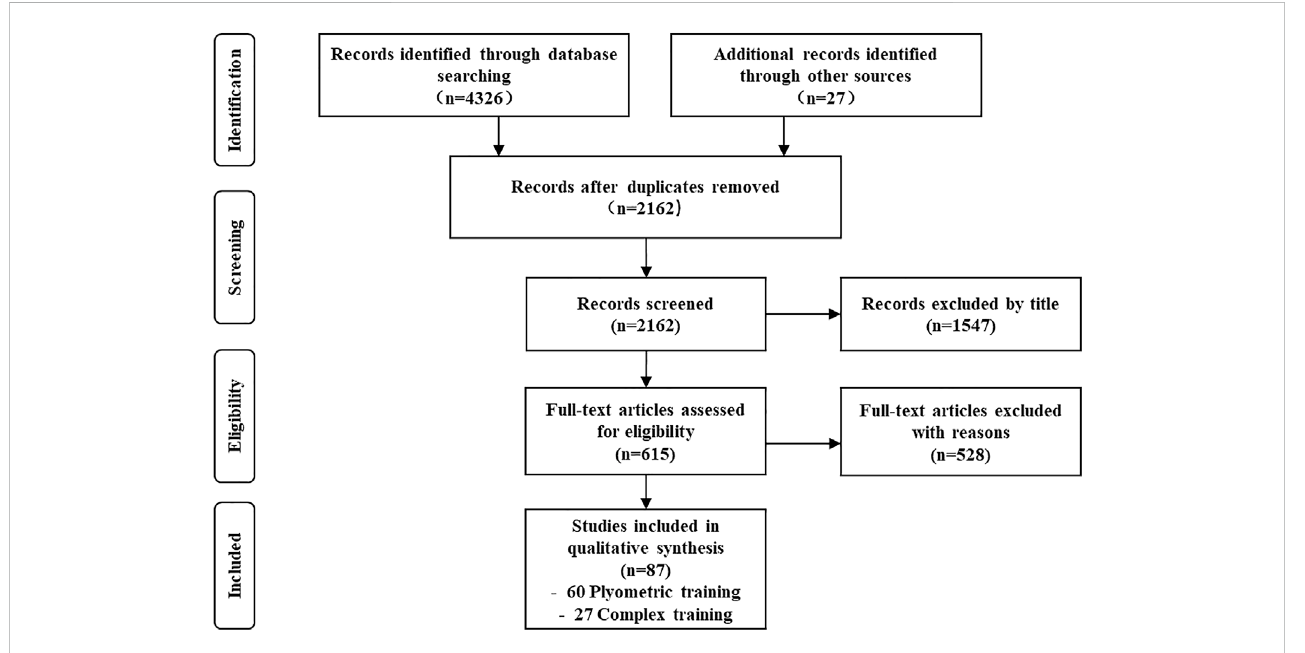
FIGURE 1 Flowchart of study selection (PLT = plyometric training, CT = complex